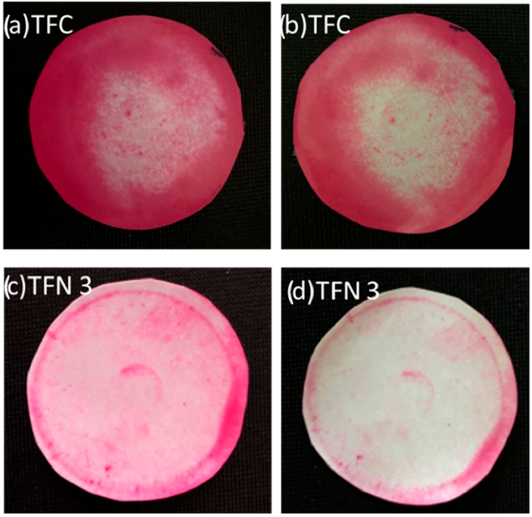
Figure 5. Photographs of the TFC membrane before ( a ) and after photocatalytic treatment ( b ); Photographs of the TFN membrane before ( c ) and after ( d ) photocatalytic treatment.